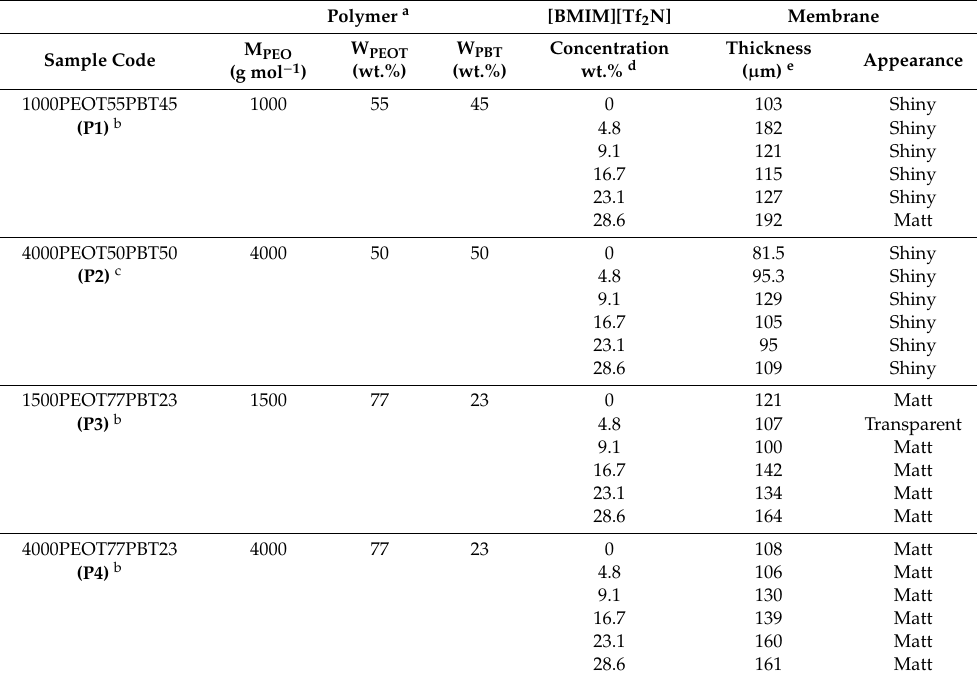
Table 1. Membrane compositions and macroscopic